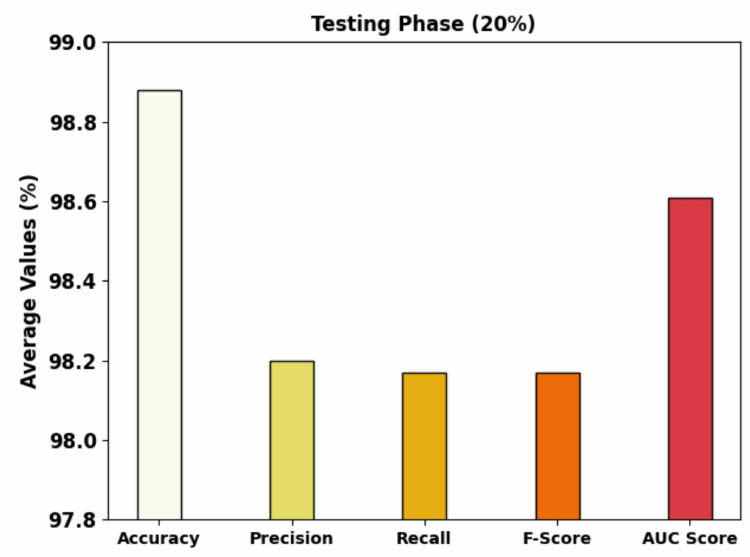
Figure 6. Average analysis of MRFOTL-GCDC system using 20% of the TS database. Table 3. Result analysis of MRFOTL-GCDC system at a 70:30 ratio of TR/TS